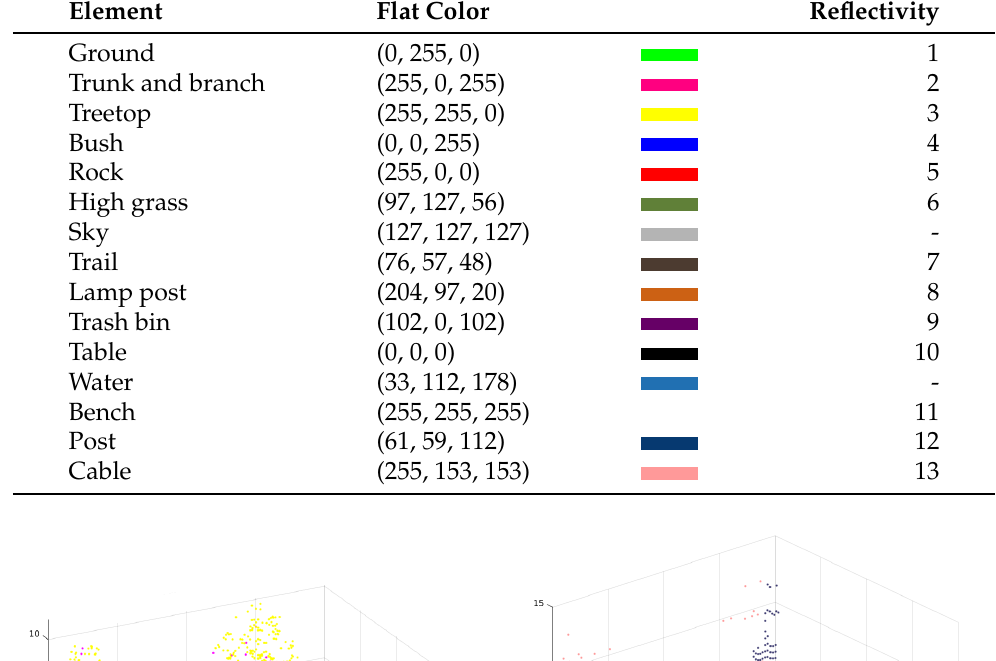
Table 3. RGB color tags and reflectivity values assigned to the elements present in the environments.